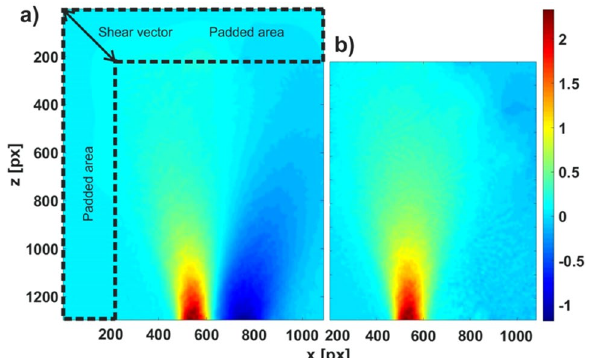
Figure 7. ( a ) Phase map with second Wollaston copy visible as a dark blue region in the right of the jet (Argon, backing pressure 1.6 bar). The area marked by the dotted line is the extension with a size corresponding to the shear vector s . ( b ) Corrected phase map of the same